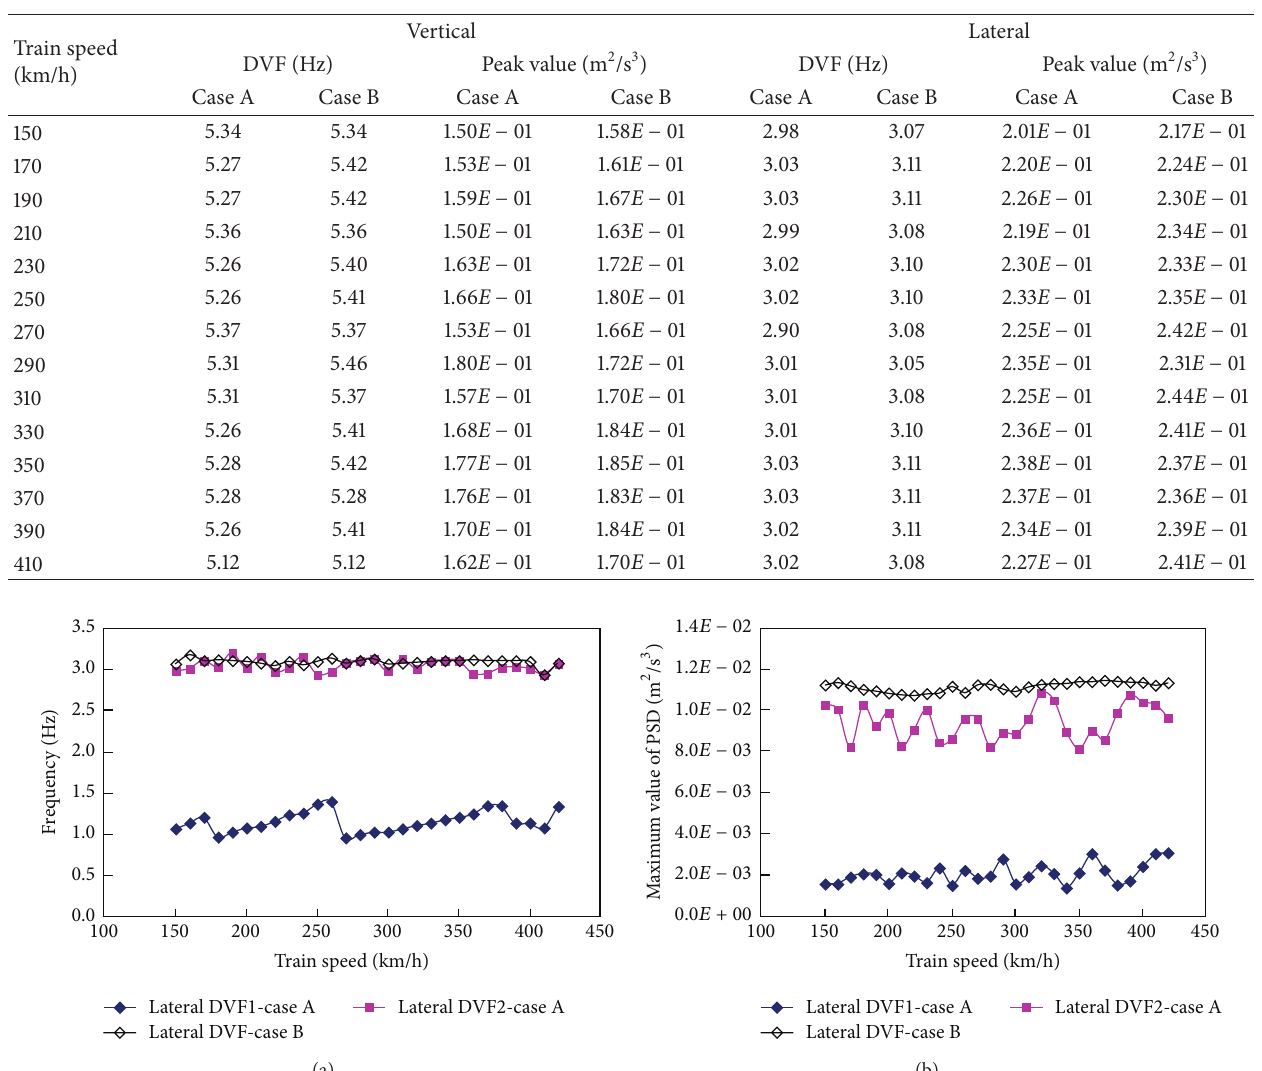
Table 4: Influence of train speed on PSDs of bridge midpoint acceleration.